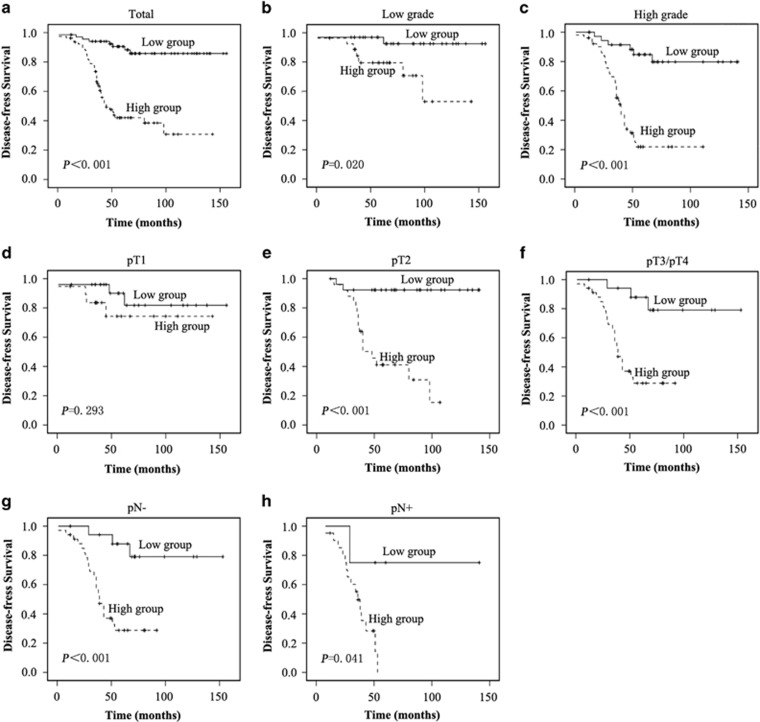
Kaplan–Meier survival curves for BUC patients after radical cystectomy according to SLC12A5 expression. (a) Significantly improved survival was observed in all BUC patients whose tumors exhibited low SLC12A5 expression versus those whose tumors exhibited high SLC12A5 expression (P<0.001). (b) Significantly improved survival was observed in low-grade BUC patients whose tumors exhibited low SLC12A5 expression versus those whose tumors exhibited high SLC12A5 expression (P=0.020). (c) Significantly improved survival was observed in high-grade BUC patients whose tumors exhibited low SLC12A5 expression versus those whose tumors exhibited high SLC12A5 expression (P<0.001). (d) Probability of survival of pT1 patients with BUC (P=0.293). (e) Significantly improved survival was observed in pT2 BUC patients whose tumors exhibited low SLC12A5 expression versus those whose tumors exhibited high SLC12A5 expression (P<0.001). (f) Significantly improved survival was observed in pT3/pT4 BUC patients whose tumors exhibited low SLC12A5 expression versus those whose tumors exhibited high SLC12A5 expression (P<0.001). (g) Significantly improved survival was observed in pN− BUC patients whose tumors exhibited low SLC12A5 expression versus those whose tumors exhibited high SLC12A5 expression (P<0.001). (h) Significantly improved survival was observed in pN+ BUC patients whose tumors exhibited low SLC12A5 expression versus those whose tumors exhibited high SLC12A5 expression (P<0.001)